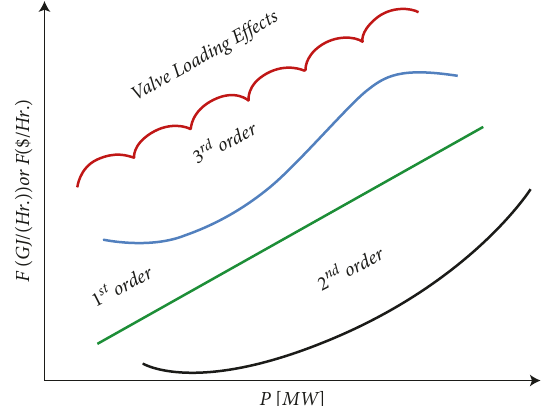
Figure 1: Smooth and nonsmooth curves model of fuel cost es- timation for a thermal